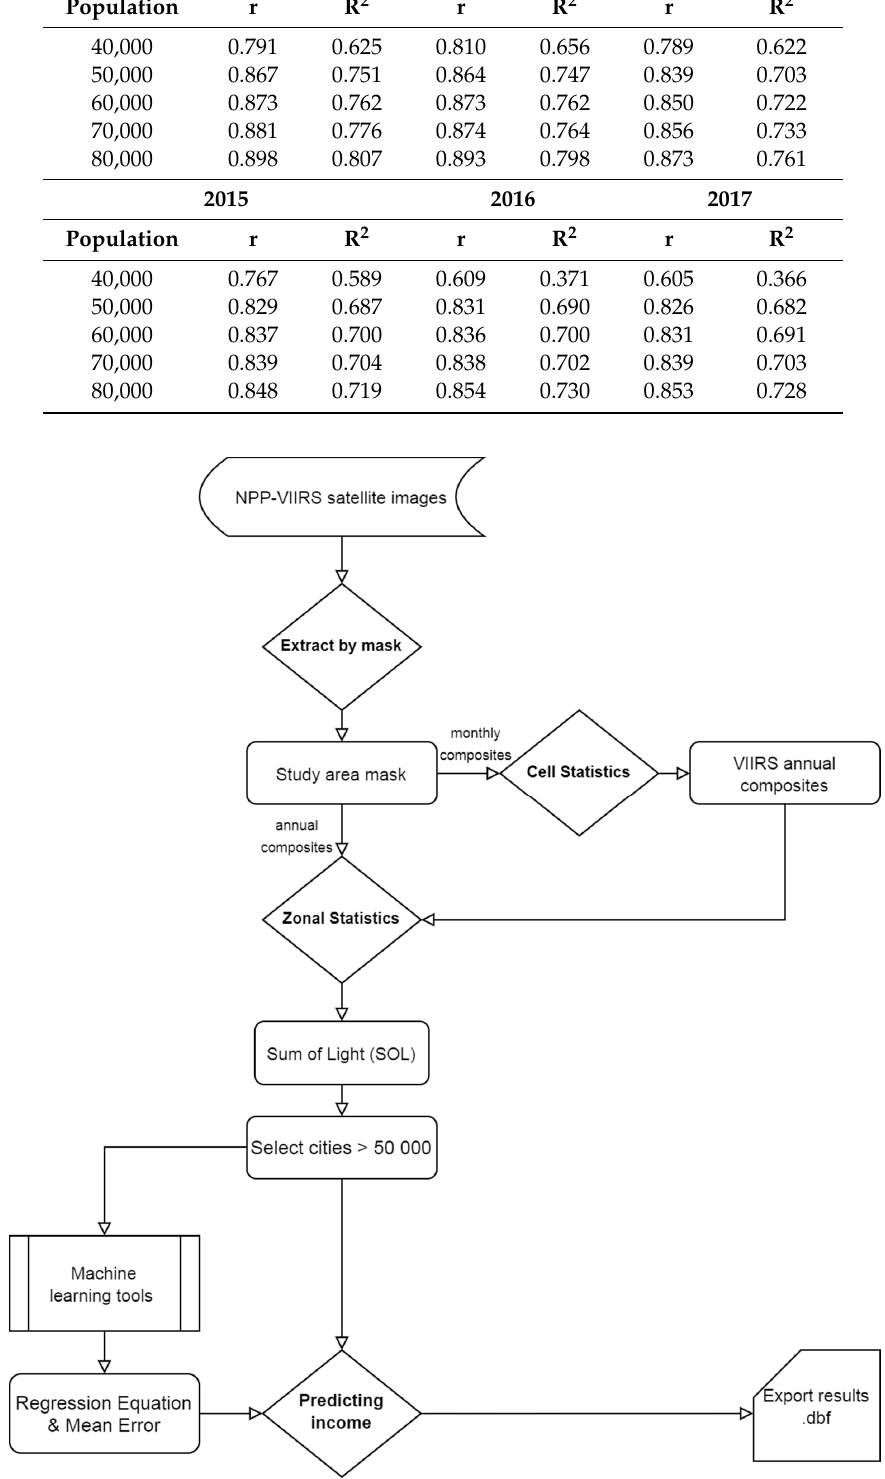
Figure 2. Flow diagram showing the steps involved in estimating income per capita for each city.